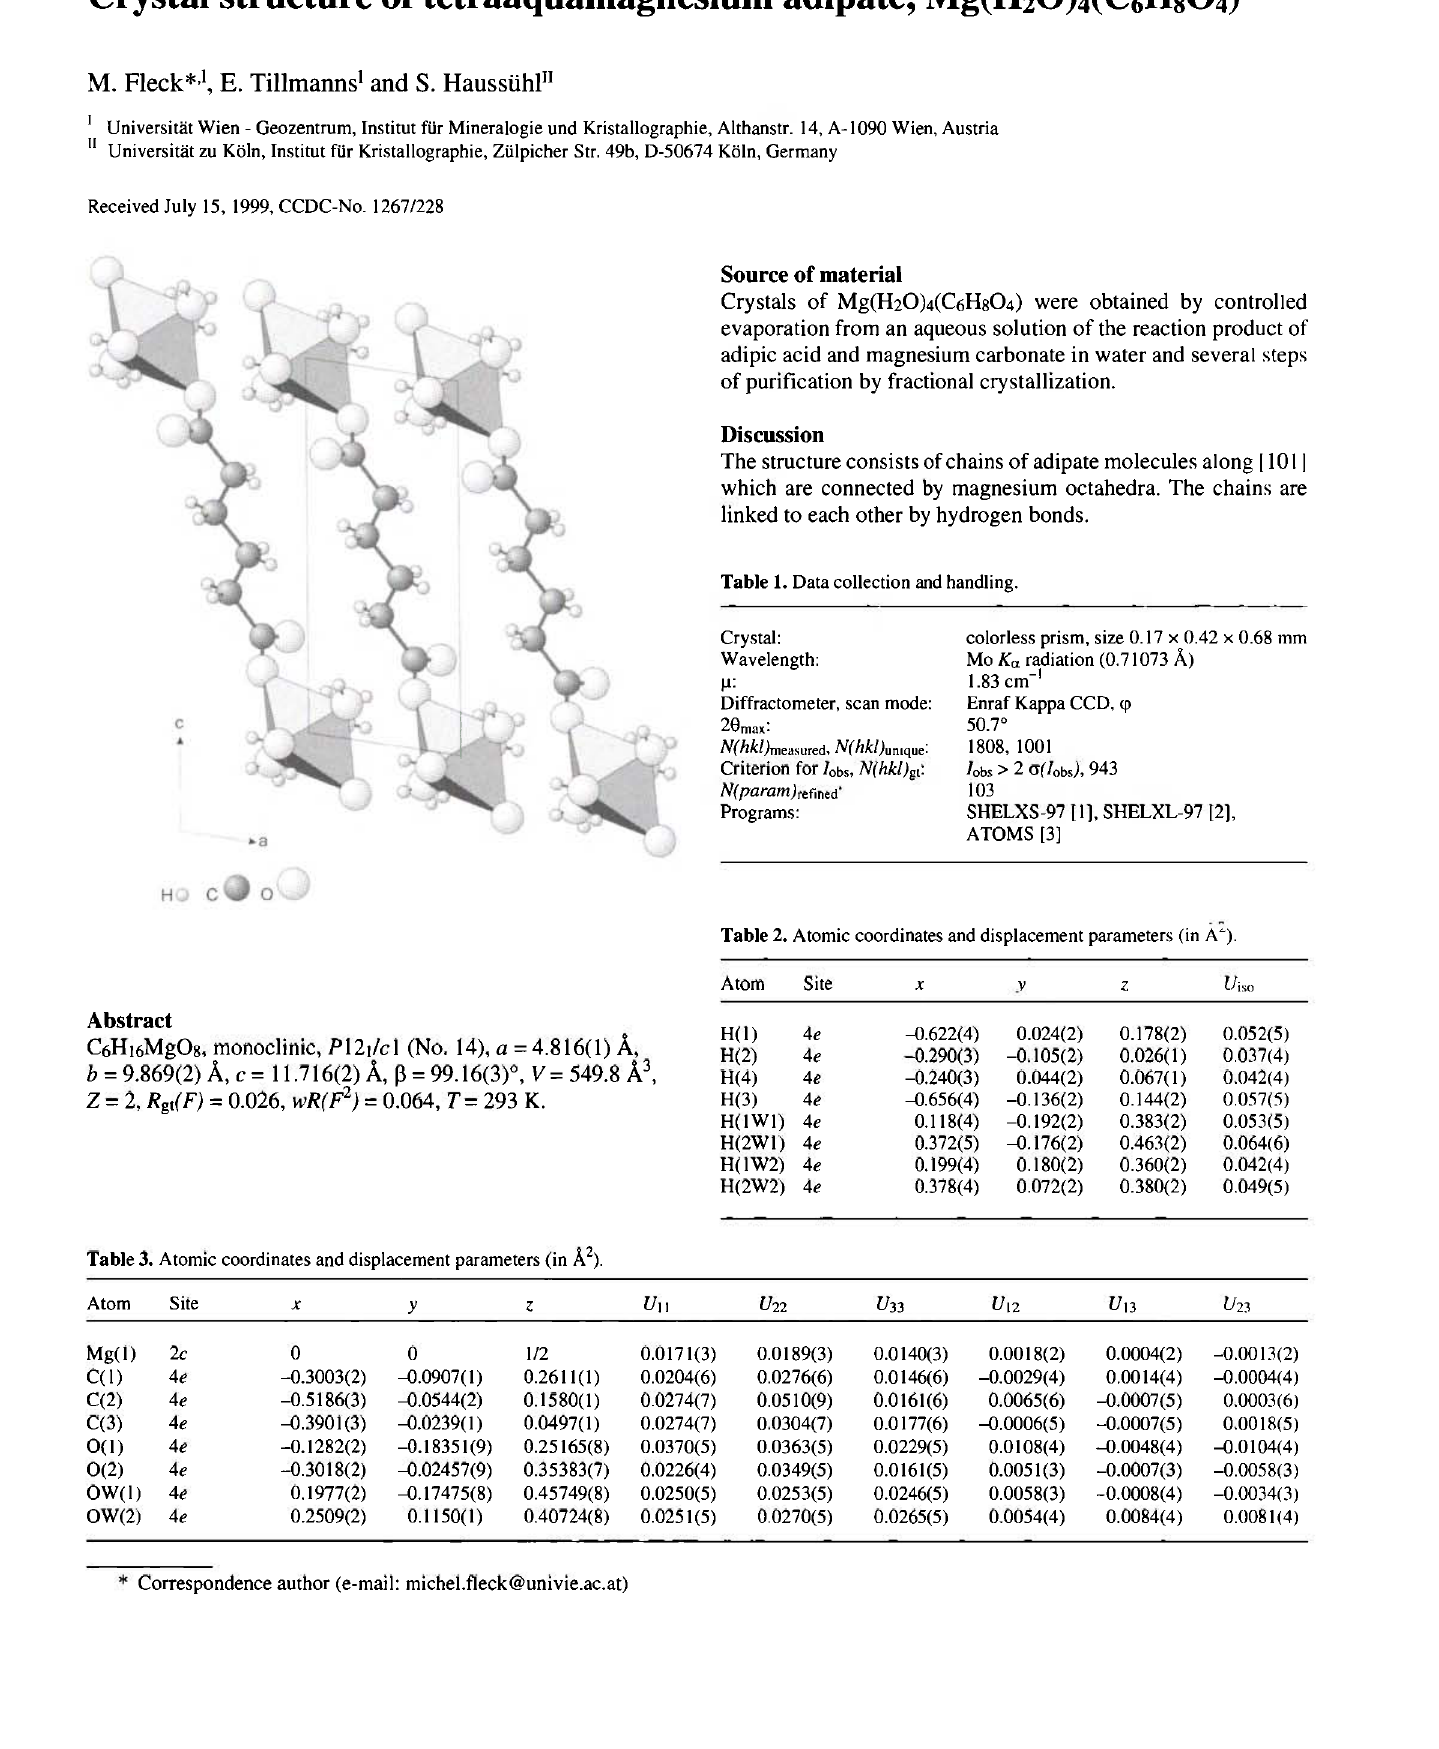
Table 1. Data collection and handling. Crystal: Wavelength: μ: Diffractometer, scan mode: 20max: N(hkl) measured, ЩШ)итци С '· Criterion for / 0 b s , N(hkl) gl : N{param)rcfmti' Programs: